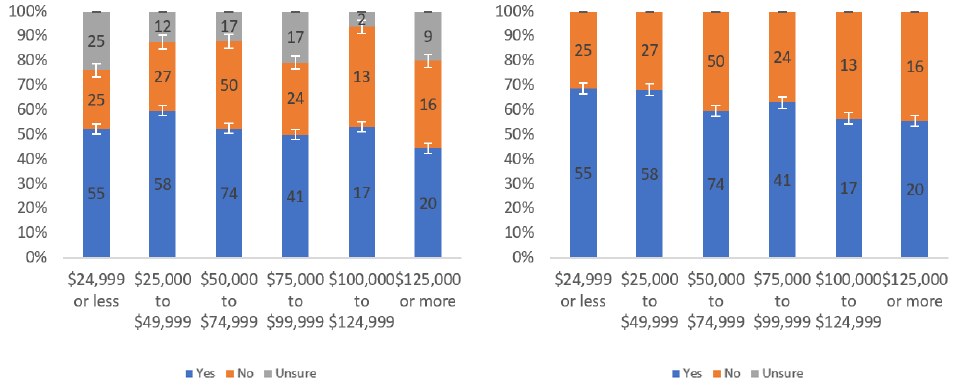
Figure A1. Responses regarding label helpfulness by income level including ( left ) and excluding ( right ) unsure responses.